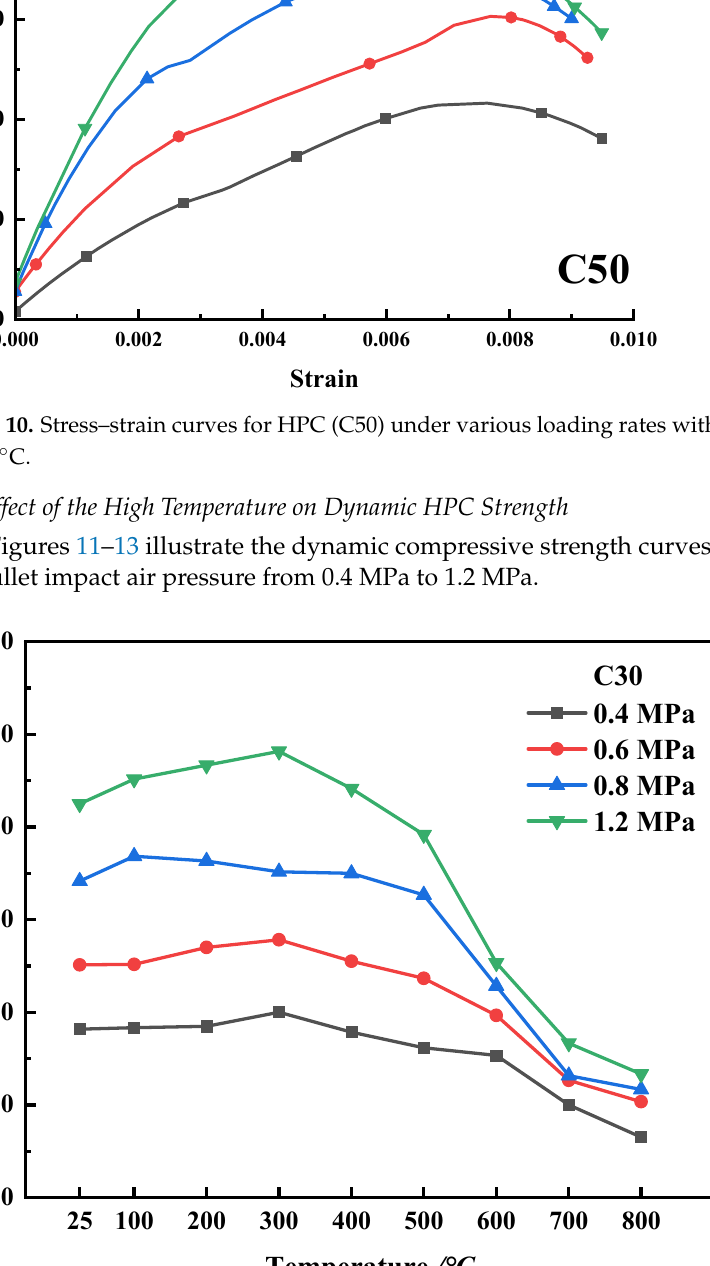
Figure 11. Dynamic compressive strength curves of concrete with grade C30.